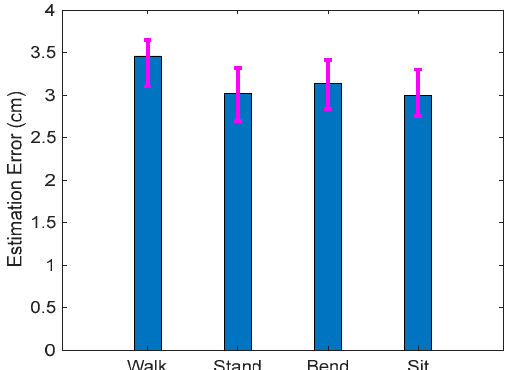
Figure 18. Error estimation for different human poses.